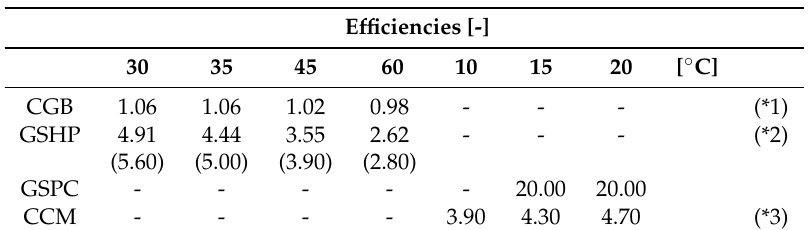
Table 2. Efficiencies (i.e the ratio between the useful thermal energy and the used electrical energy) of production components based on values from technical datasheets (TS) and Annex 48 [39]. In the case of Ground Source Heat Pump (GSHP), the given efficiency corresponds to the Seasonal Performance Factor (SPF) assuming a circulation pump power of 2.5% of the heat pump thermal power. The Coefficient of Performance (COP) is given in brackets and it is evaluated for a source temperature of 5 ◦